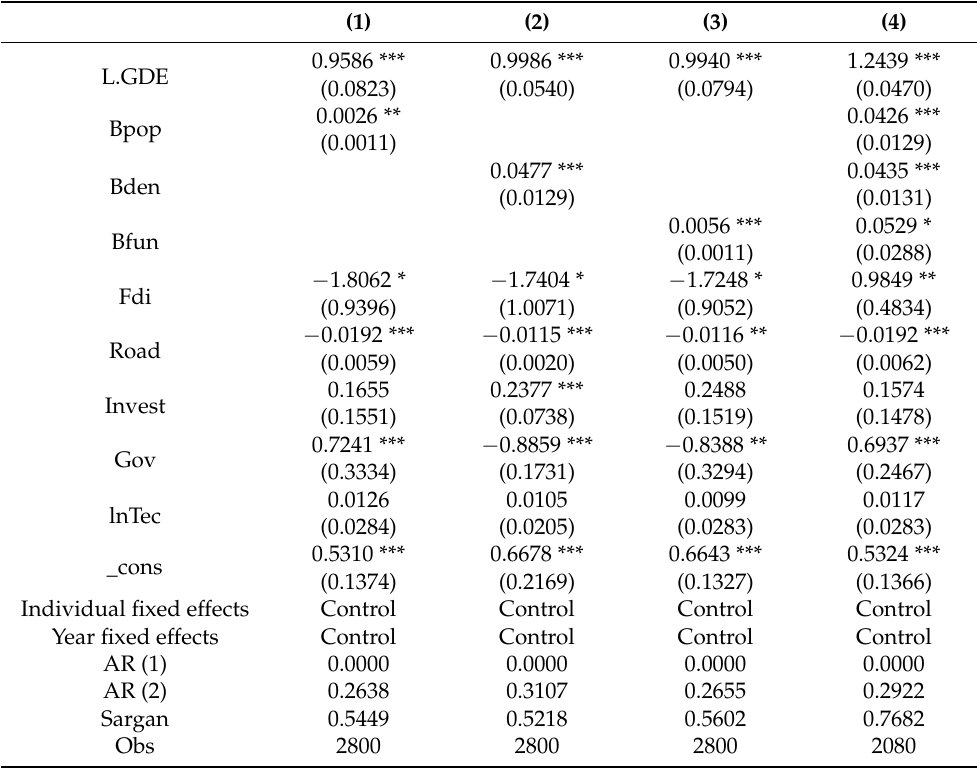
Table 9. Results of systematic generalized method of moments